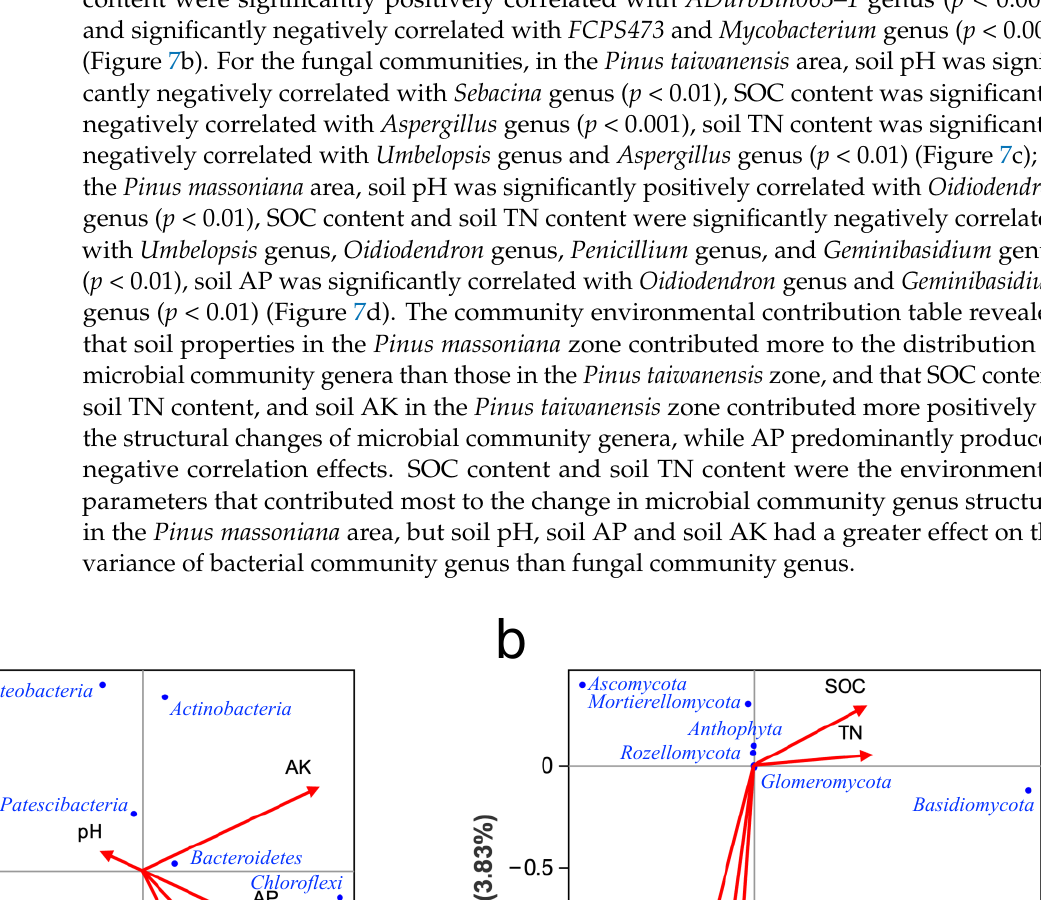
−− −− Figure 6. Redundancy analysis (RDA) between elevation and soil properties (red arrows) and the dominant (relative abundance) bacterial ( a ) and fungal ( b ) phyla in different forest soils. SOC, Soil organic carbon; TN, Total nitrogen; AP, Available phosphorus; AK, Available potassium.